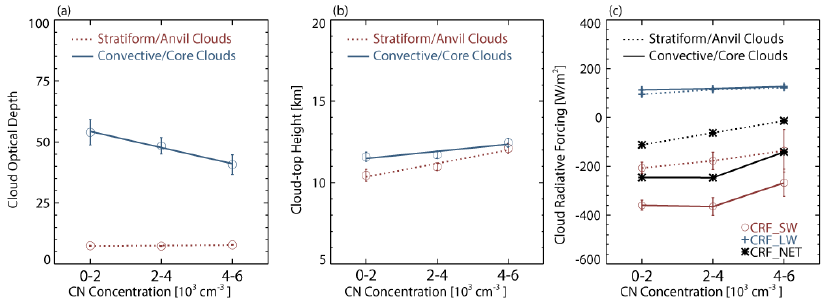
Figure 5. Deep convective cloud (a) optical depth, (b) top height, and (c) radiative forcing (SW, LW, and net) as a function of aerosol CN concentration. Solid lines are for convective cores and dotted lines represent